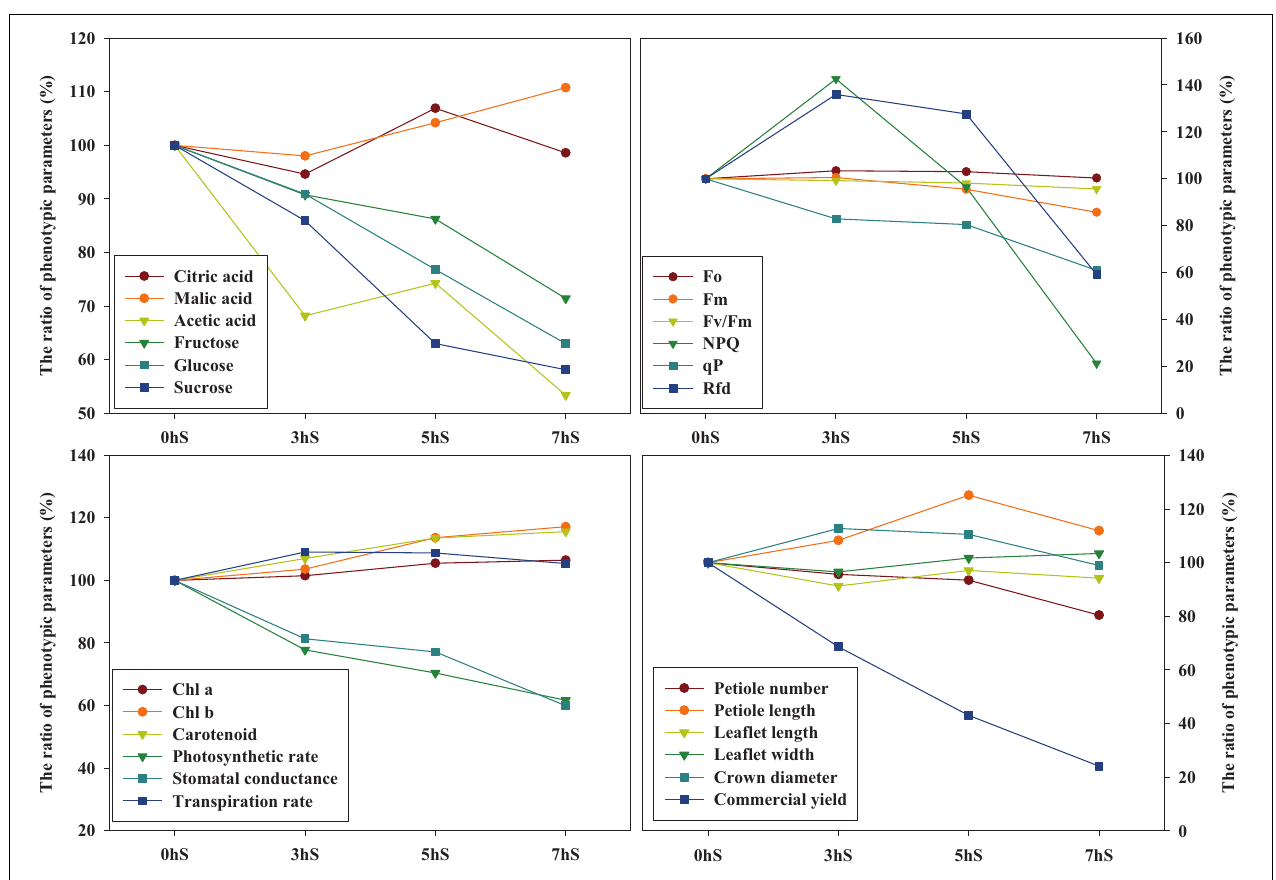
FIGURE 7 | Relationship of graph patterns among phenotypic parameters of strawberry ( Fragaria × ananassa ) plants based on the 0 hS (100%). The graph pattern according to the ratio change of phenotypic parameters of strawberry plants for each light intensity level was used the statistically analyzed mean values in Tables 1 , 3 , 4 , and Figures 2 – 5 . Chl a , chlorophyll a ; Chl b , chlorophyll b ; F o , minimum fluorescence when all photosystem II (PSII) reaction centers (RCs) are open; F m , maximal fluorescence when all PSII RCs are closed; F v / F m , maximum quantum yield of PSII photochemistry; NPQ, non-photochemical quenching of maximal fluorescence; qP, photochemical quenching of variable fluorescence; R Fd , fluorescence decline ratio in light. 0 hS: non-shading treatment (control); 3 hS, three hours of shading until 10:00; 5 hS, five hours of shading until 12:00; 7 hS, seven hours of shading until